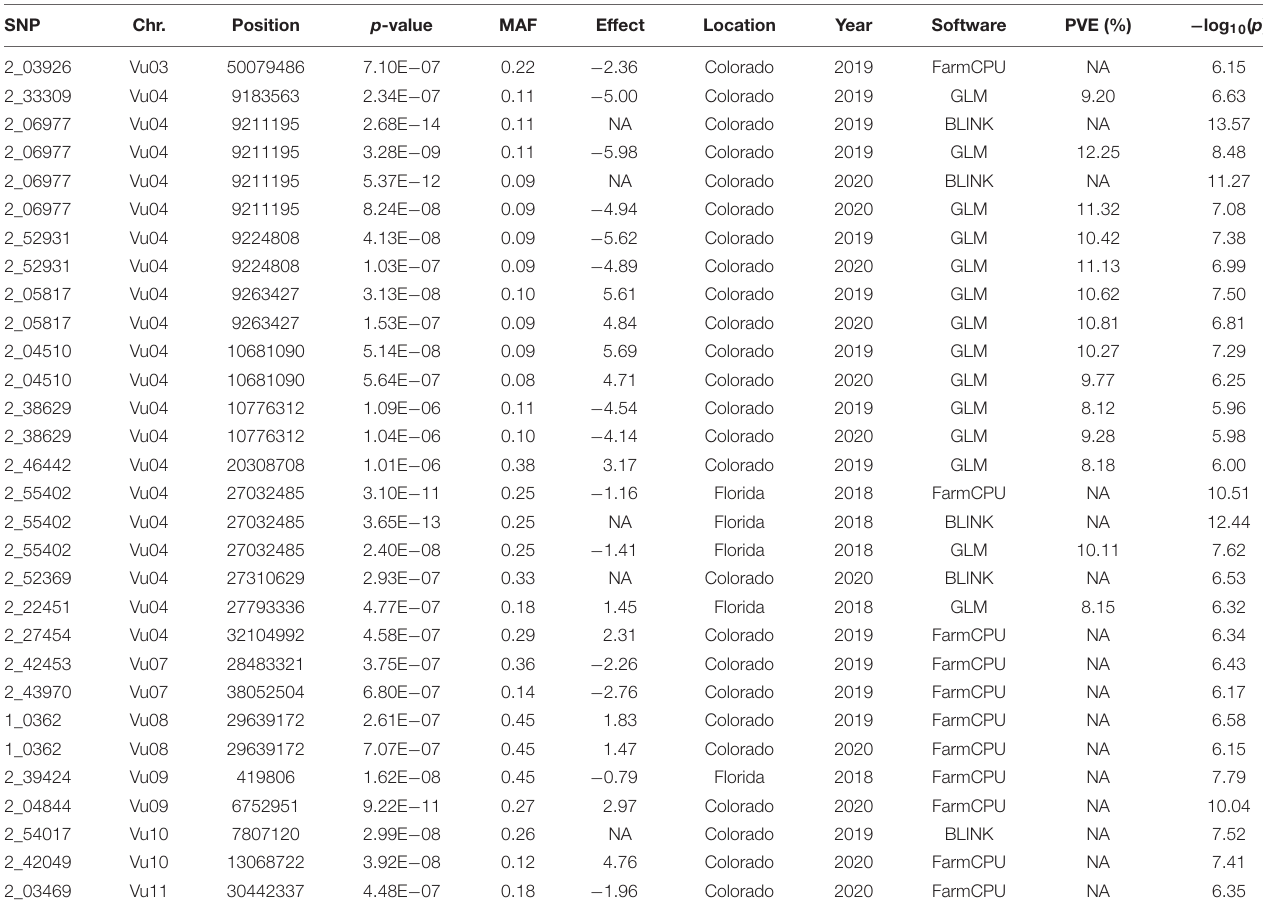
TABLE 2 | Significant SNPs related to days to flowering identified by multiple algorithms in genome wide association studies in the three studies along with their p -value, minor allele frequency (MAF), effect, percentage of variance explained [PVE(%)] as reported by each software, and − log 10 ( p ). SNP Chr. Position p -value MAF Effect Location Year Software PVE